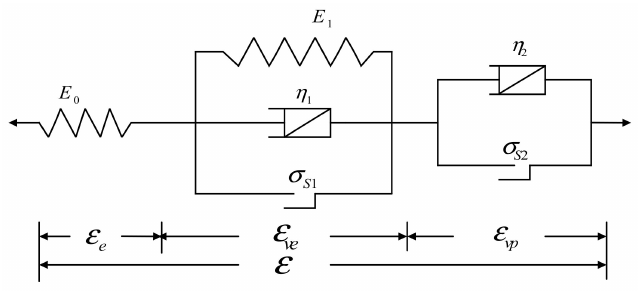
Figure 2. Creep Constitutive